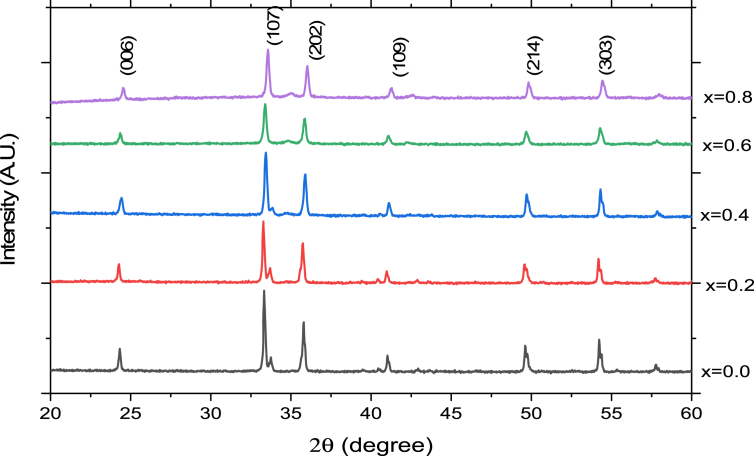
XRD pattern of CaAlxFe12-xO19.